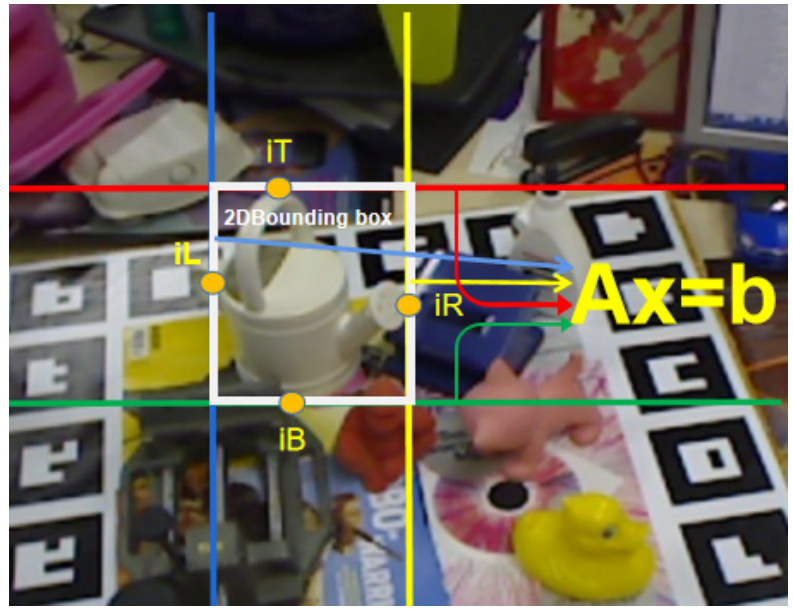
Figure 5. The point-to-side correspondence. The object’s surface was made up of a large number